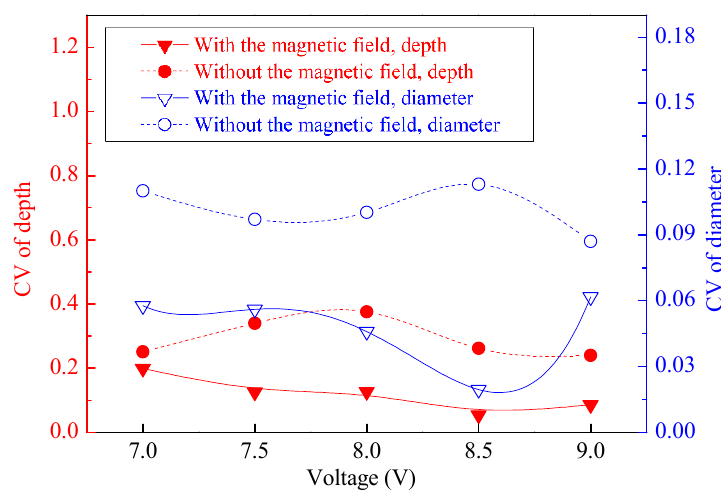
Figure 6. Change in dimensions of machined arrayed micro ‐ dimples with the applied voltage and with or without magnetic field (single ‐ travel time of 0.3 s).